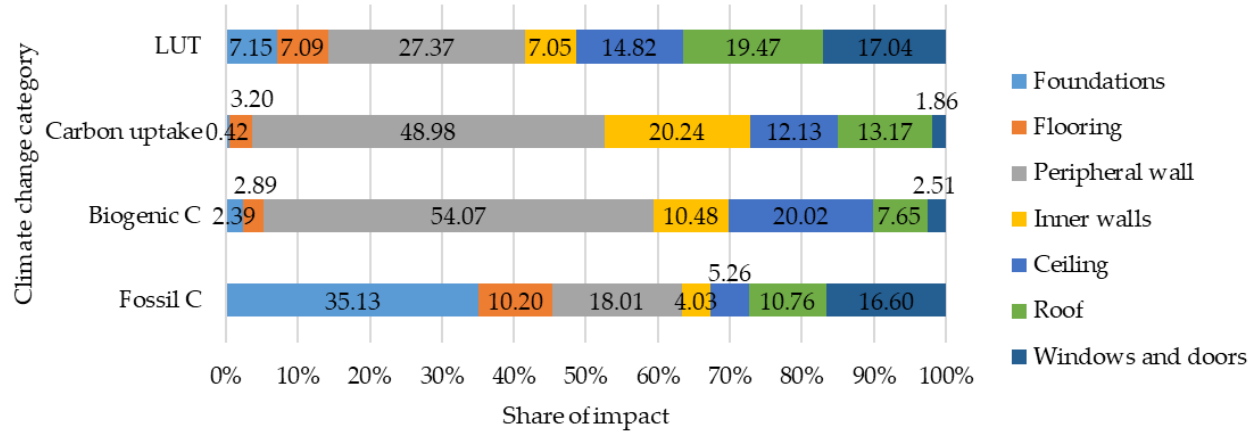
Figure 7. Impact distribution of construction components on climate change.